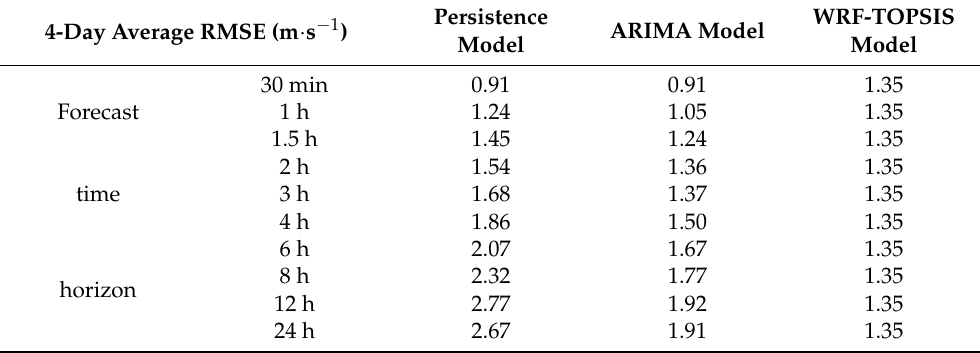
Table 9. Four-day average root mean squared error for the wind speed forecasting using the persis- tence, ARIMA, and WRF-TOPSIS models applied to the 4-day test